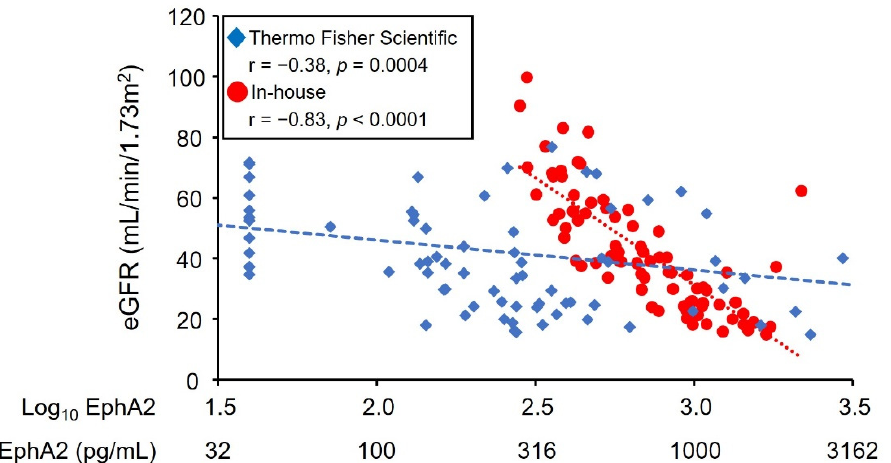
Figure 1. The correlation between EphA2 concentrations and eGFR. Spearman’s correlation coeffi- cients revealed that EphA2 levels had a significant negative correlation with eGFR.